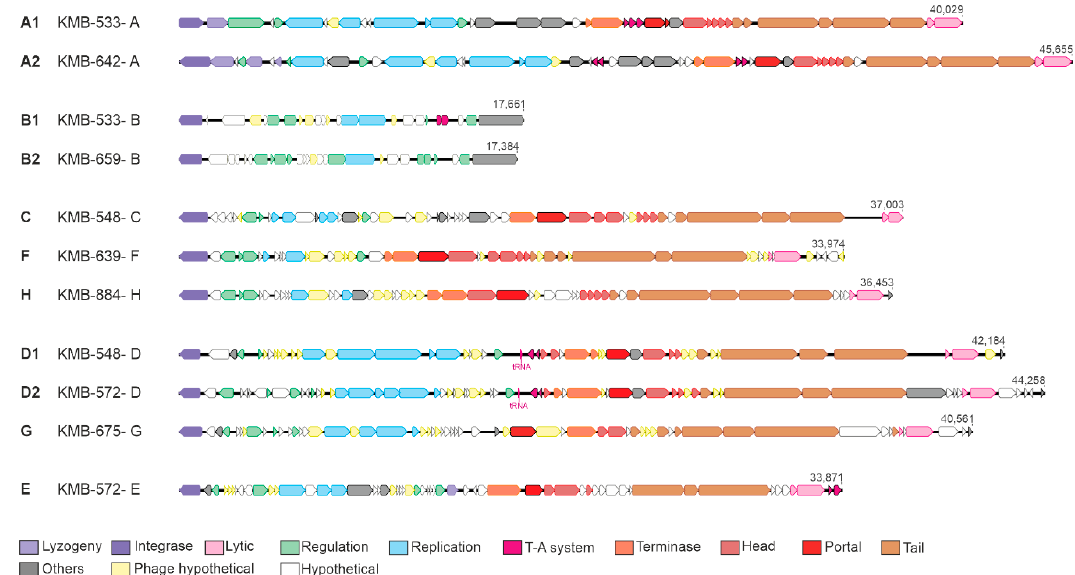
Figure 3. Genome maps of representative prophages belonging to A–H groups. Table 1. Prophages in GBS sequenced genomes.